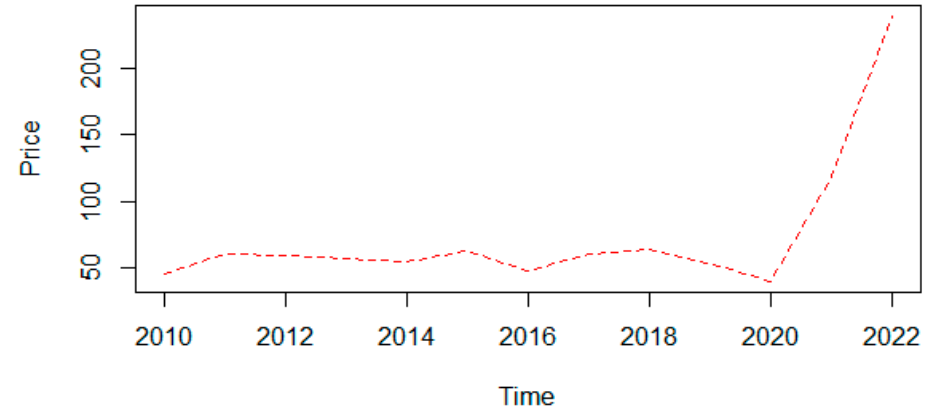
Figure 3. The monthly price of electricity in Spain (in euros per megawatt-hour). Source: Own elaboration from Statista and Rstudio [77]. Table 3. The ARIMA Model.